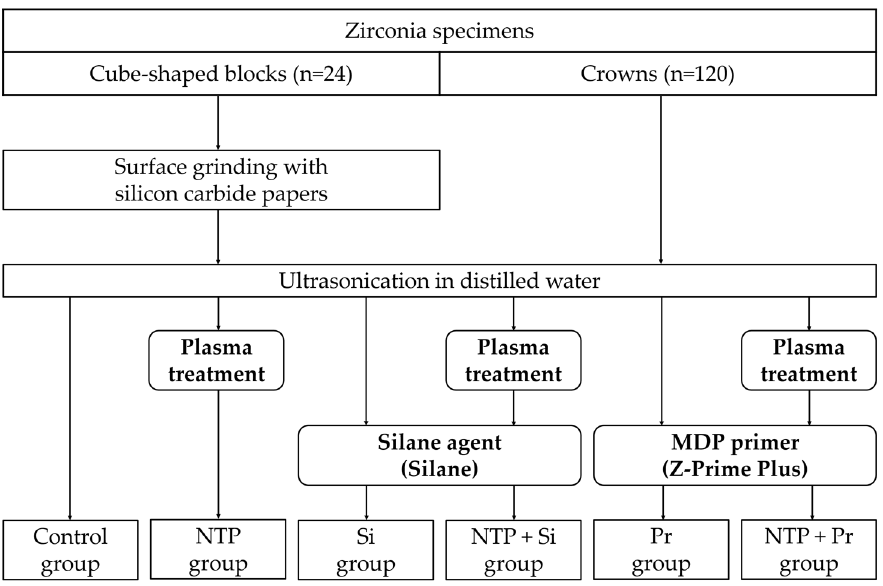
Figure 2. A process of lab analog embedding and titanium abutment fixation. ( a ) CAD data of the jig. ( b ) 3D printing process. ( c ) 3D-printed jig and lab analog. ( d ) Lab analog in the jig hole. ( e ) Lab analog embedded in acrylic resin. ( f ) Titanium abutment fixed to a lab analog with 35 Ncm torque. ( g ) Filling screw hole using Teflon tape. ( h ) Complete lab analog-titanium abutment connection.